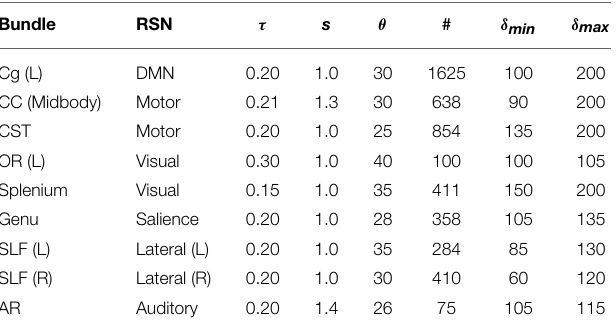
TABLE 3 | Bundle-specific tractography parameters used for each